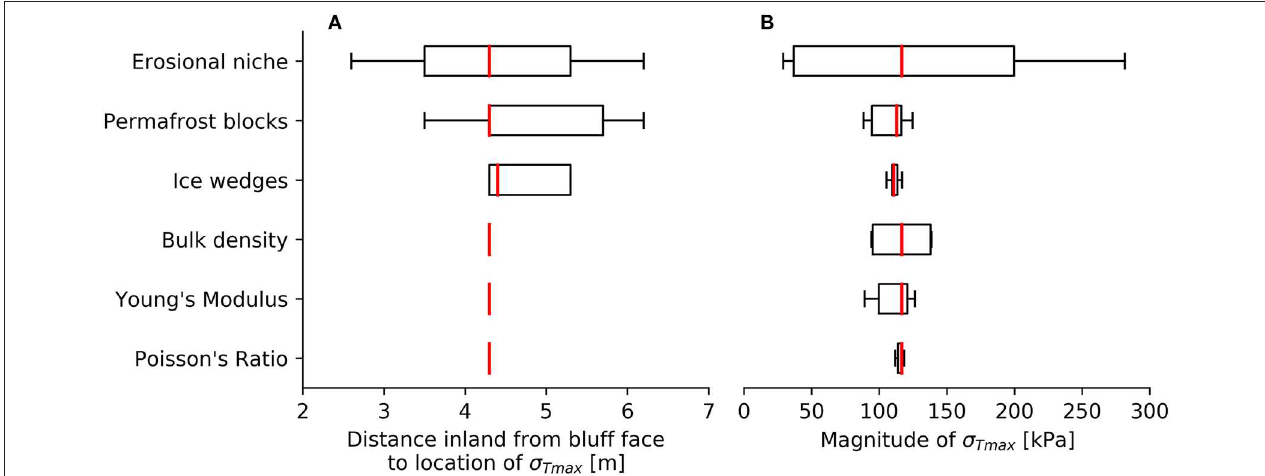
FIGURE 5 | Boxplots showing the impact of variability in geometric (i.e., erosional niche, permafrost block, and ice wedge) characteristics and ice/permafrost material properties (i.e., bulk density, Young’s Modulus, and Poisson’s Ratio) on the (A) location and (B) magnitude of the simulated maximum tensile stress ( σ Tmax ). Geometric and material parameter values are reported in Table 1